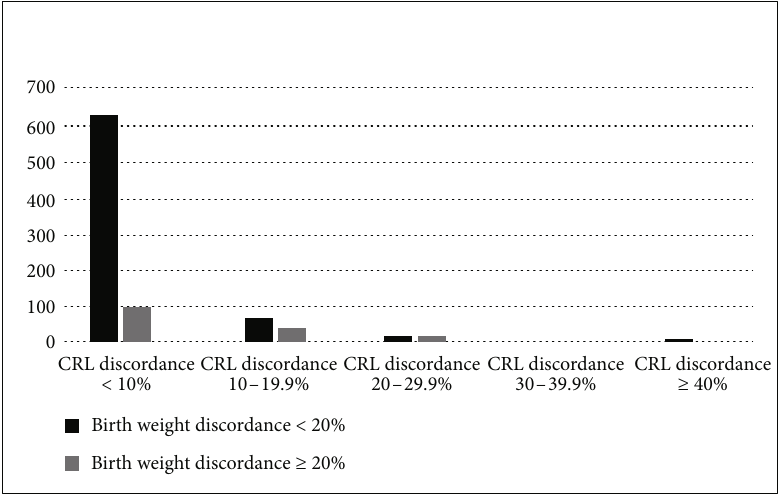
Figure 2: Crown rump length and birth weight discordance distribution. Table 2: Multivariate probability modeling the e ff ect of CRL discordance ≥ 10% on birth weight discordance. Odds ratio